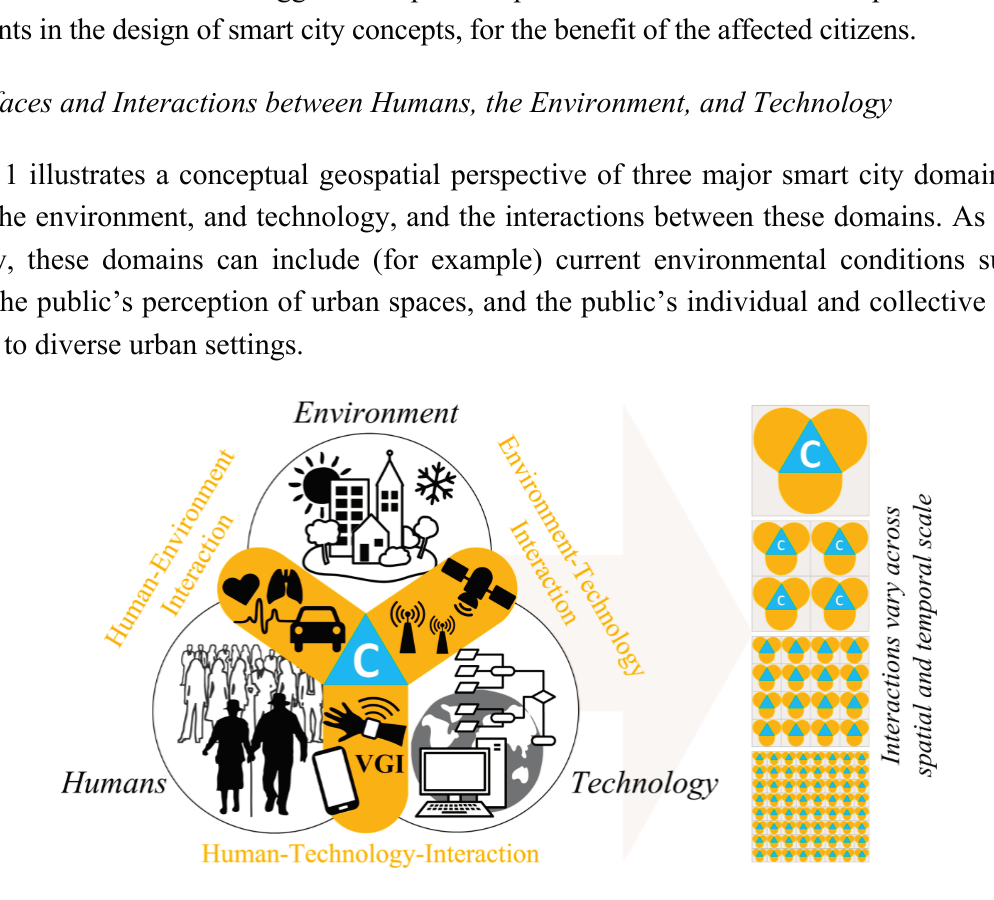
Figure 1. Model of smart city interactions between humans, the environment, and technology. The interfaces (in orange) between humans, the environment and technology represent the interactions between these domains, which vary across spatial and temporal scales (right side of the figure); the context (blue) is a key component at the common intersection of these